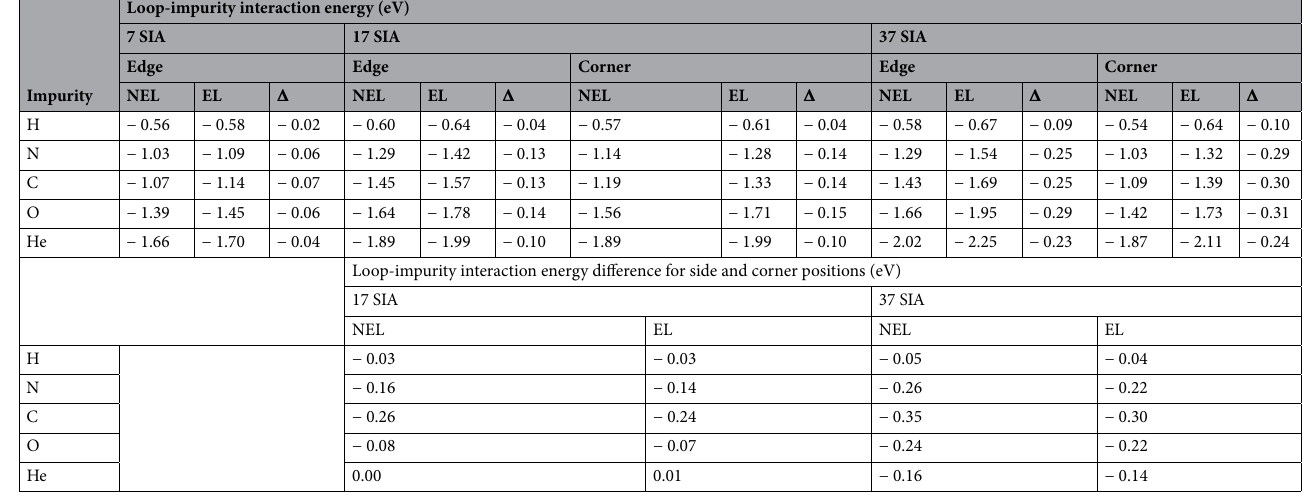
Table 2. Interaction energy between dislocation loops and impurities in different positions with (EL) and without (NEL) elastic correction. The difference of these values ( (cid:31) ) is also